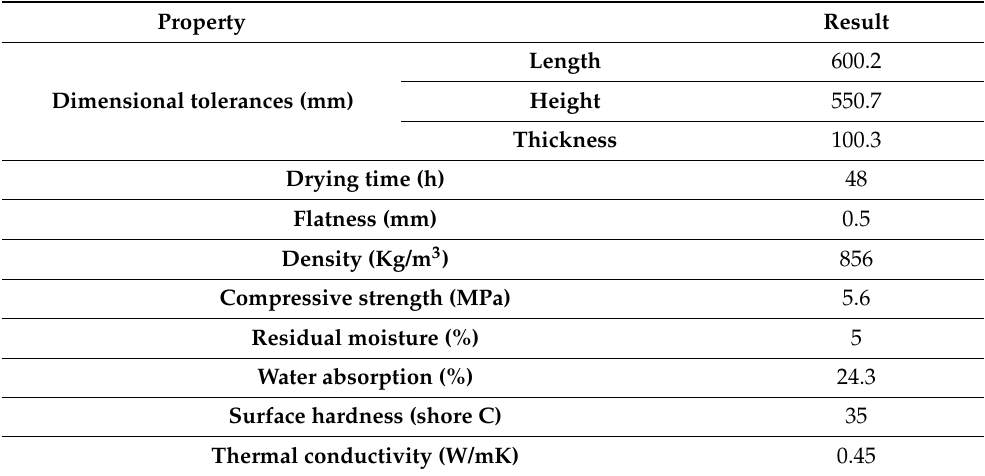
Table 7. Mechanical and physical properties of gypsum plaster blocks.